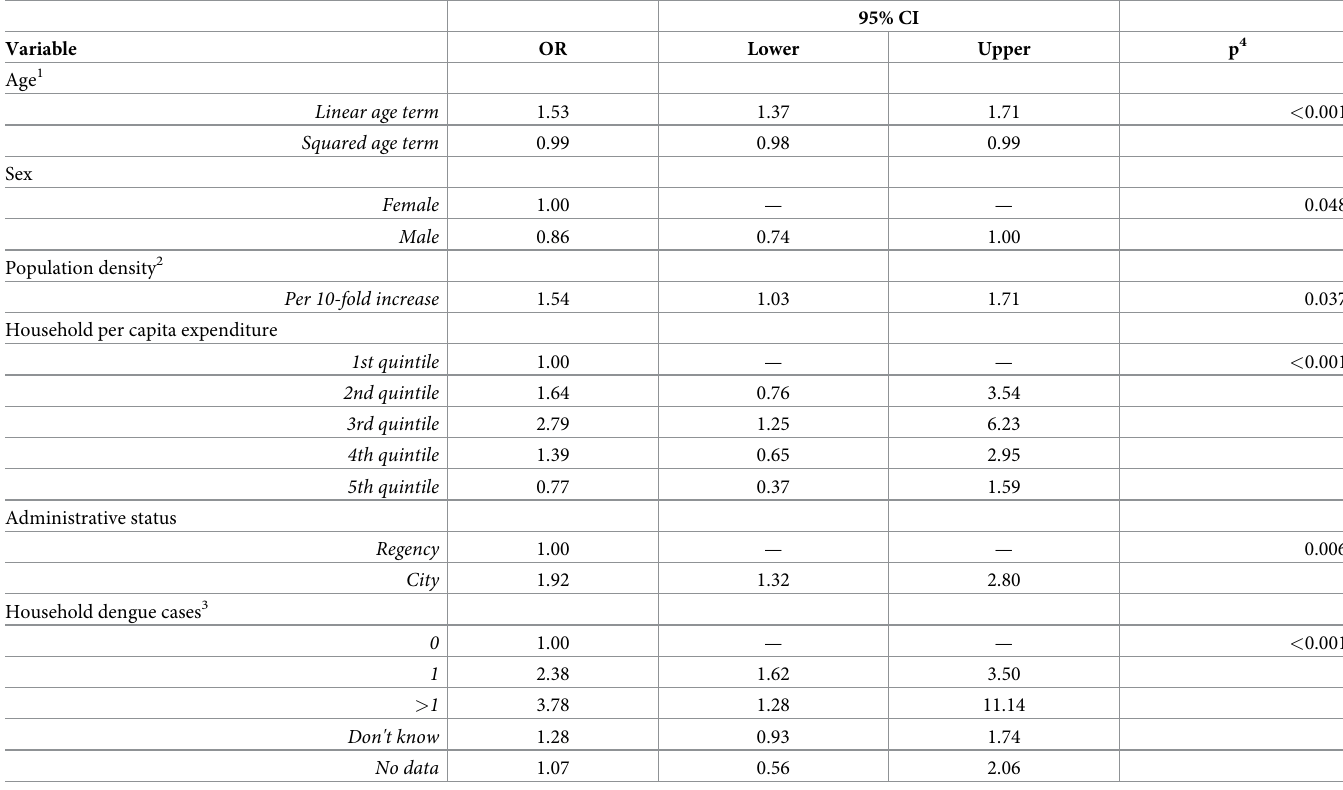
Table 1. Factors associated with dengue seropositivity in children aged 1–18 years, results from multivariable population-averaged effects model, Indonesia